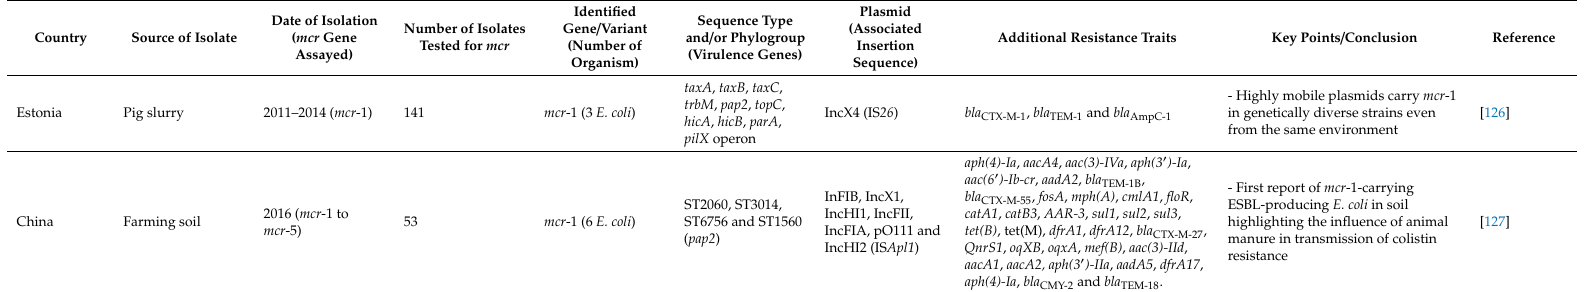
Table 5. Studies reporting plasmid-mediated colistin resistance in isolates from soil / manure ecosystem.